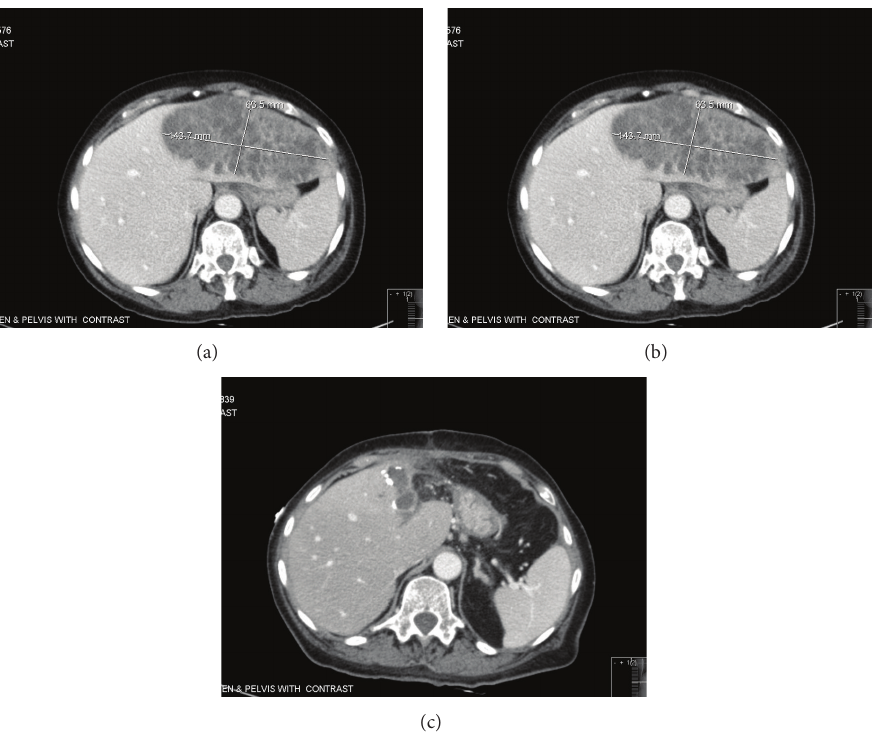
Figure 1: (a) Computed tomographic scan of the abdomen pelvis prior to IR drainage showing left liver abscess measuring 13.5 × 7.4 × 10.3 cm. (b) Computed tomographic scan of the abdomen pelvis 2 days after the IR drainage of 200 cc fluid, showing increase in abscess size to 16 × 7 cm. (c) Computed tomographic scan of the abdomen pelvis 5 weeks following left partial liver lobectomy and antibiotics showing abscess size reduced to 5.3 × 3.9 ×